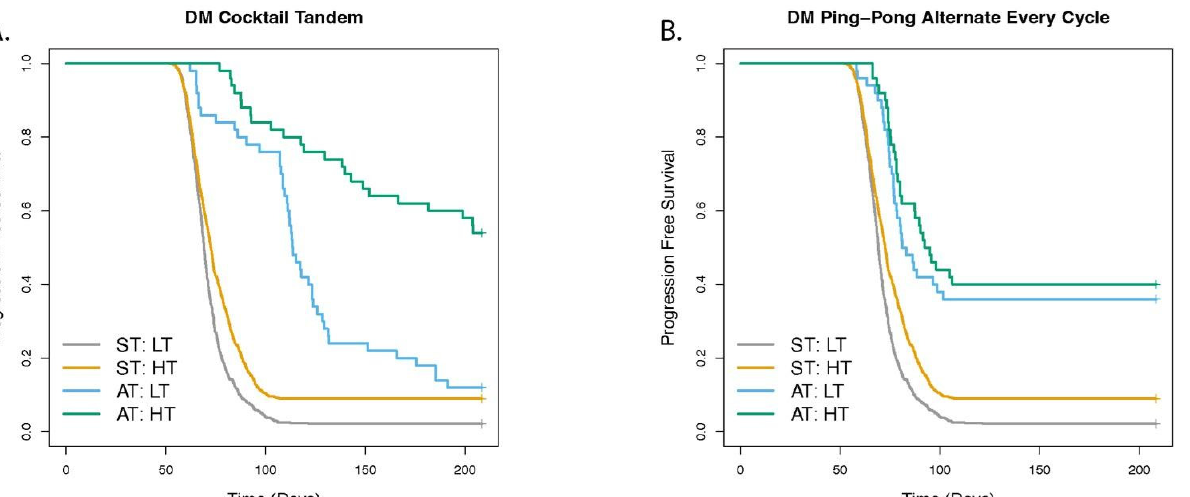
Figure 6. Effect of turnover on outcome of adaptive therapy with 2 drugs. The panels show the comparison of adaptive therapy (AT) versus standard treatment (ST) as turnover is varied while keeping the doubling time and net growth rate identical for A. DM Cocktail Tandem, B. DM Ping-